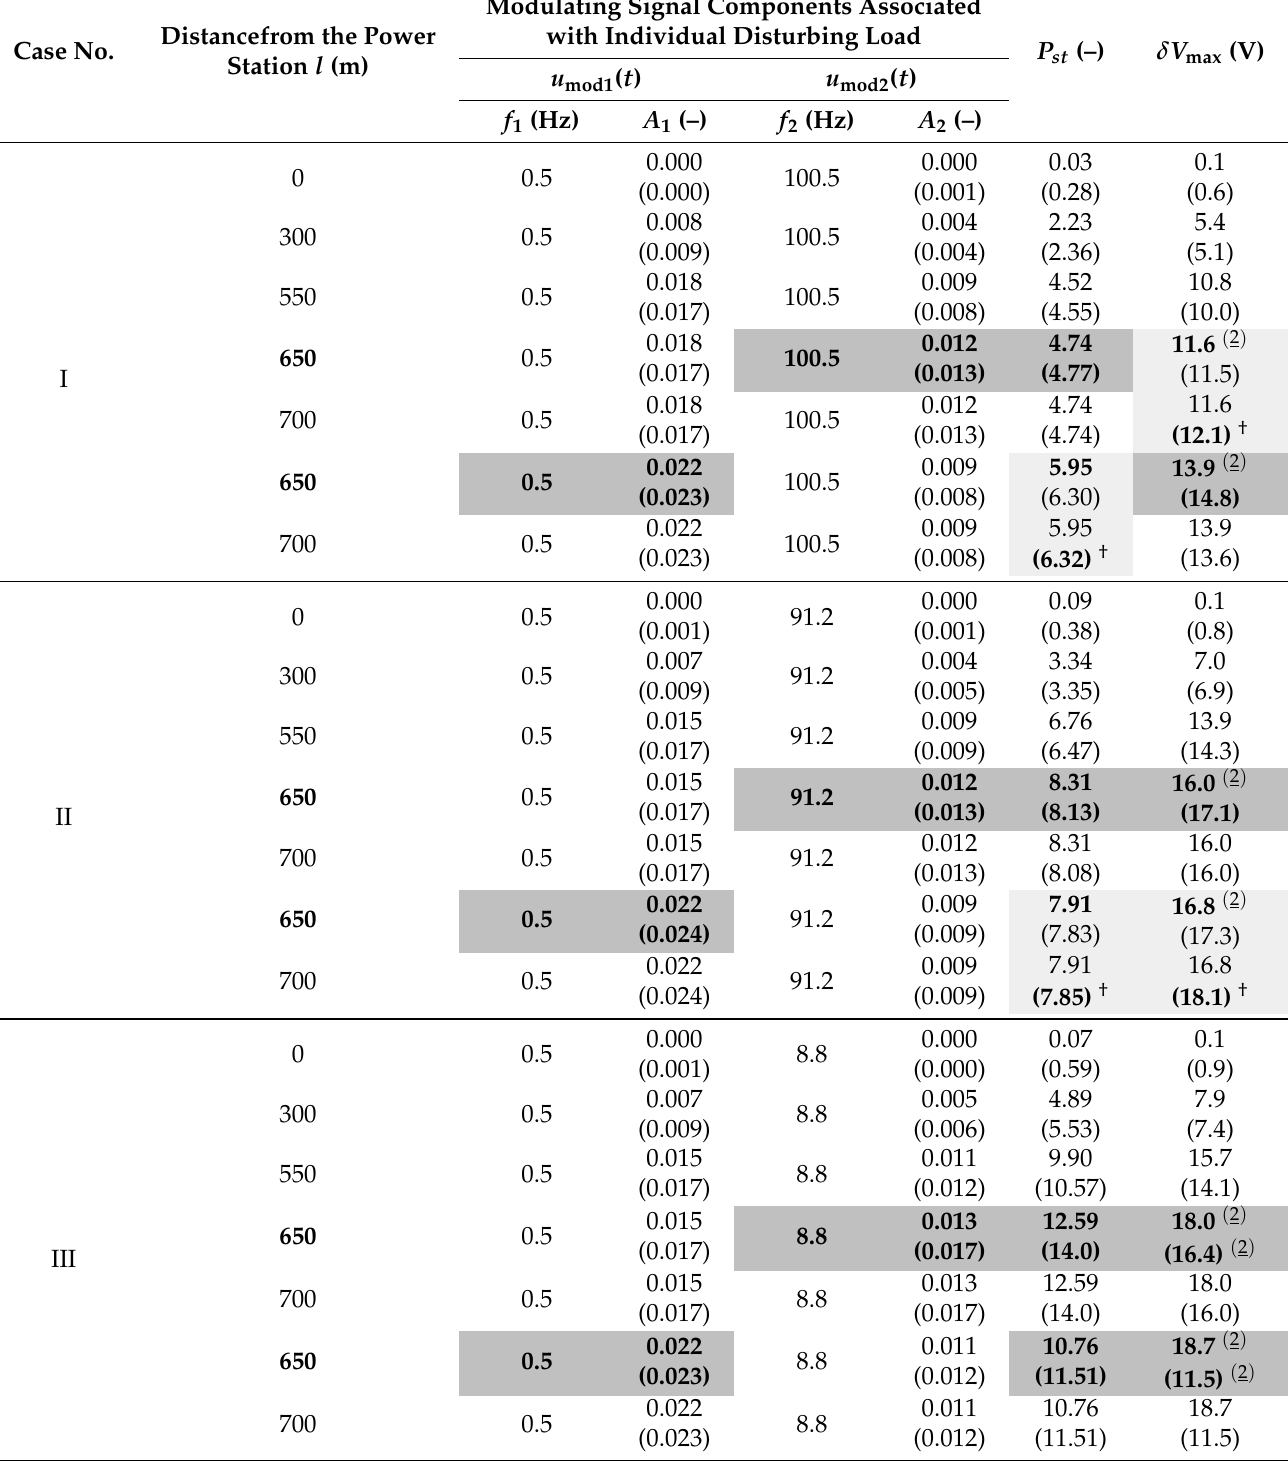
Table 9. The simulation and experimental (in brackets) research results in the real power grid—Line 4.